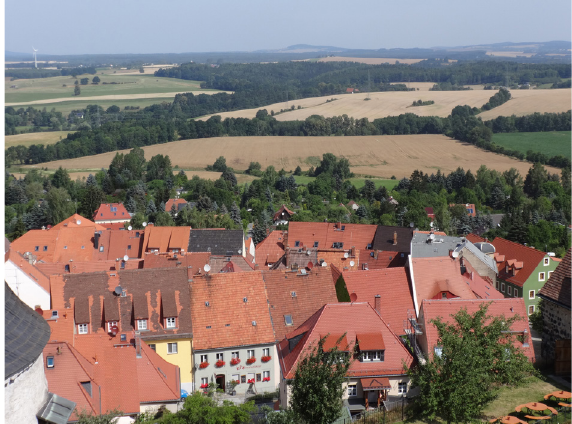
fig. 3b. Typical landscape of the surroundings of Stolpen (Germany). Mixed “rural-urban landscape”. Source: the